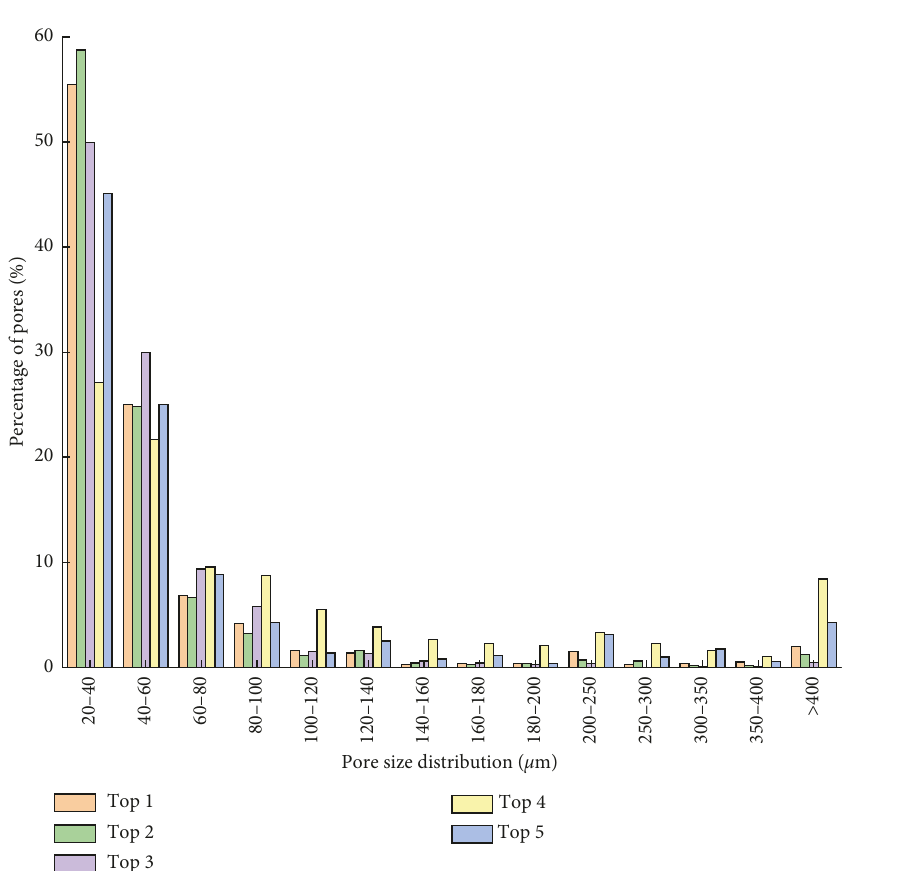
Figure 4: Pore size distribution of the aerated concrete block